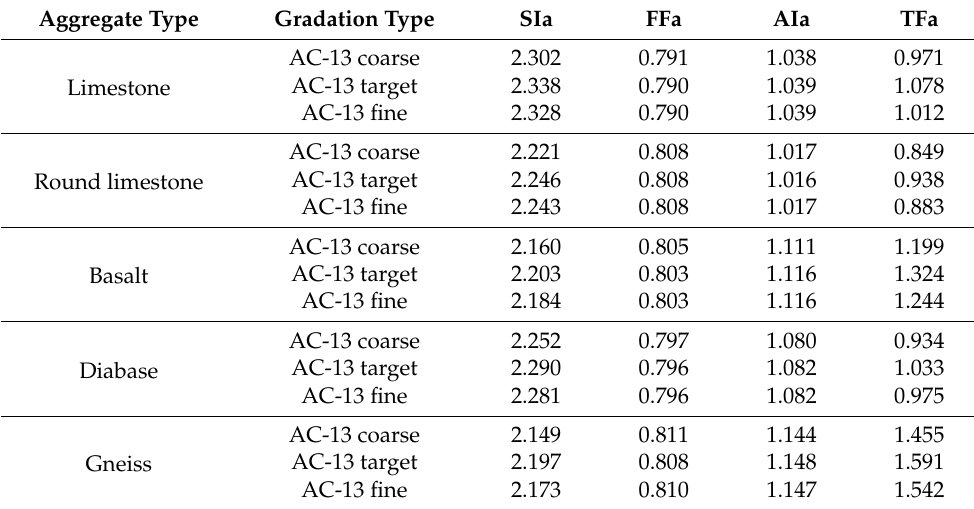
Table 6. Geometric property results of aggregates in the